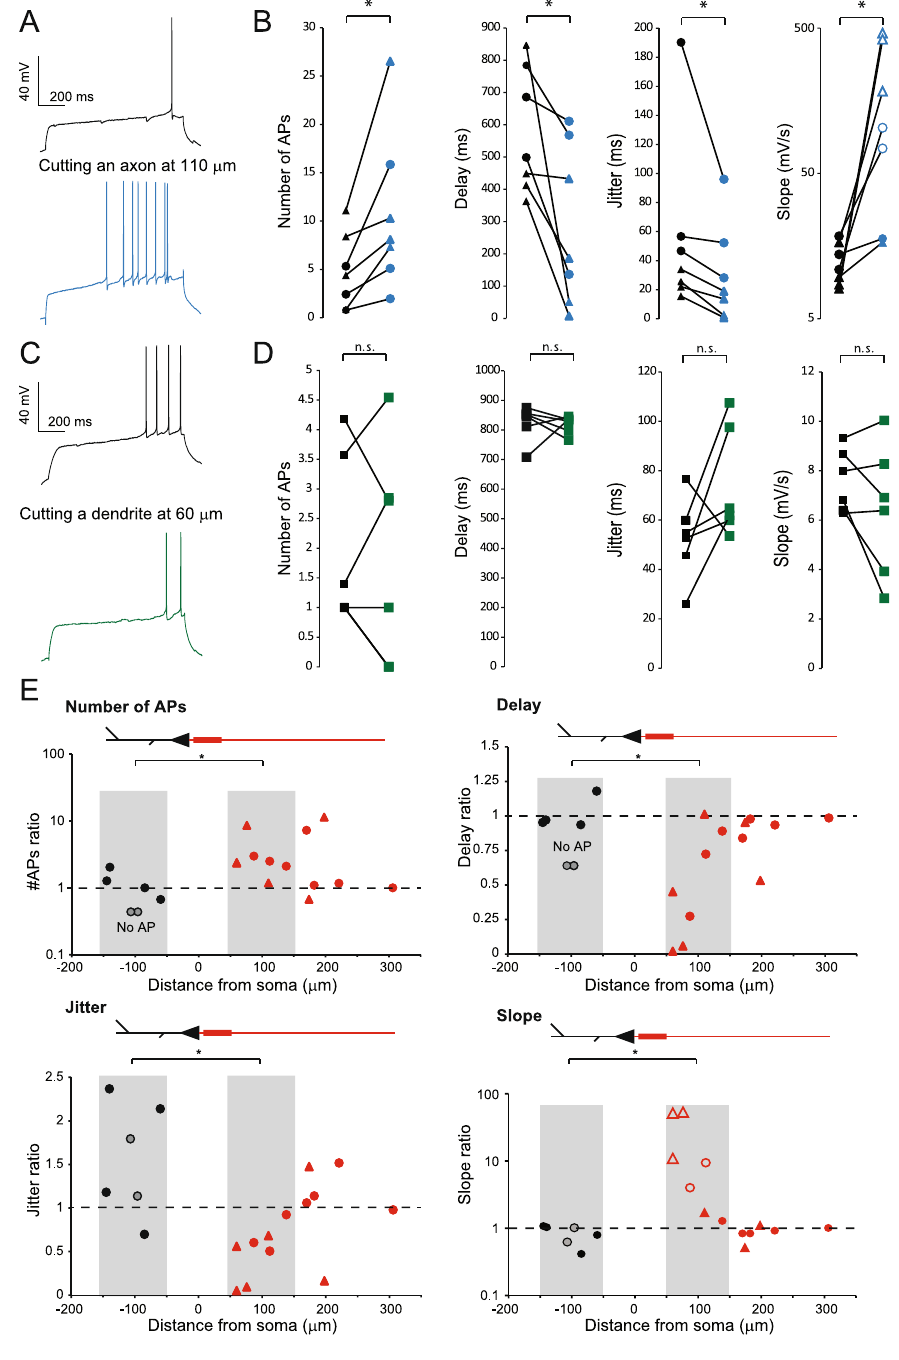
Figure 5. Excitability is increased by axon section but not dendrite section. ( A ) Typical example showing the excitability before (top) and after (bottom) axon resection or burning. ( B ) Pooled data of the effects of axon resection or burning on the spike number, the delay to the first spike, the jitter and the depolarizing slope (n = 7) Star: Wilcoxon test, p < 0.05. Triangle: burning, Circles: cutting. Note that the empty circles in the slope panel correspond to slopes measured 20 ms (and not 100 ms) before the first spike because the delay was too short. ( C ) Typical example showing the excitability before (top) and after (bottom) dendrite resection. ( D ) Pooled data of the effects of dendrotomy on the spike number, the delay to the first spike, the jitter and the depolarizing slope (n = 6). ( E ) Relative effects of dendrotomy and axotomy as a function of the distance from soma, on AP number, delay, jitter and slope. Black circles: dendrite cut; grey circles: dendrite cuts resulting in a disappearance of APs during the depolarizing step. Red circles: axon cut; Red triangles: axon burn. Grey areas on each graph correspond to the experiments used for statistics in Fig. 5B and